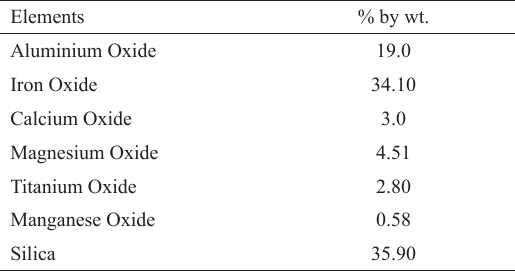
Al Si O ) 3 2 3 12